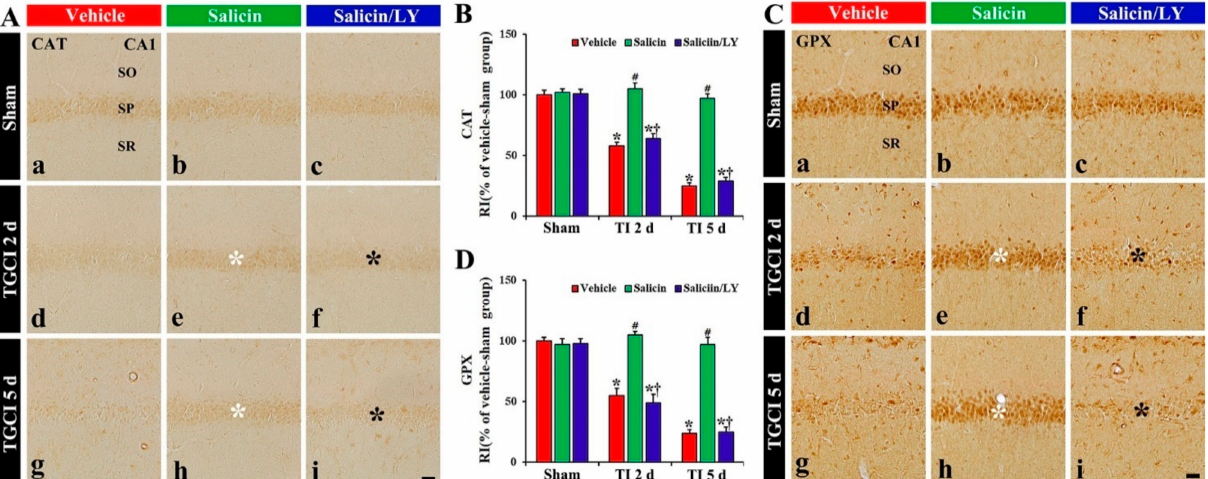
Figure 6. ( A , C ) CAT ( A ) and GPX ( B ) immunohistochemistry in CA1 of the vehicle-treated (left columns), salicin-treated (middle columns), and salicin/LY-treated (right columns) groups at sham ( Aa – Ac , Ca – Cc ), 2 days ( Ad – Af , Cd – Cf ), and 5 days ( Ag – Ai , Cg – Ci ) after TI. In the salicin-TI group, CAT and GPX immunoreactivity are not decreased in the pyramidal cells (white asterisks) after TI. However, the two immunoreactivities (black asterisks) in the salicin/LY-TI group are significantly reduced similar to those in the vehicle-TI group. Scale bar = 50 µ m. ( B , D ) RI of CAT ( B ) and GPX ( D ) in the pyramidal cells. The bars indicate the means ± SEM ( n = 5 at each time, * p < 0.05 vs. each sham group, # p < 0.05 vs. vehicle-TI group, † p < 0.05 vs. salicin-TI group; the vehicle-sham group was regarded as control